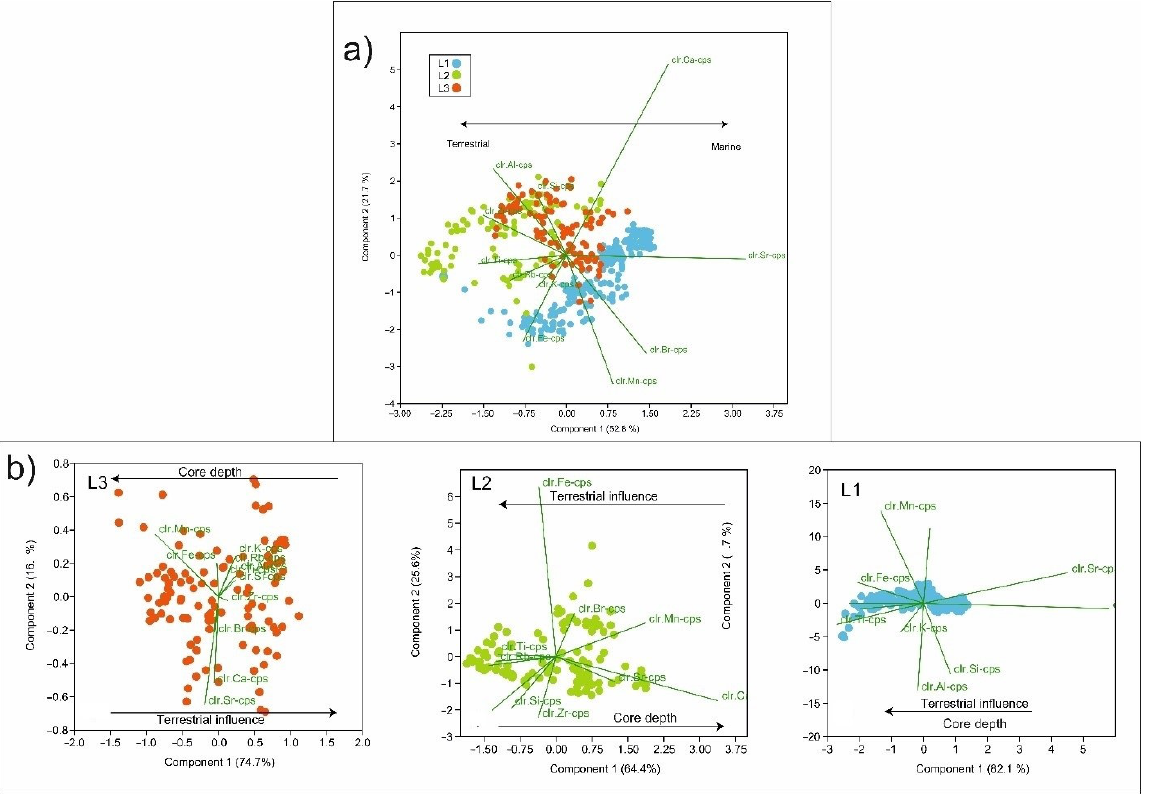
Figure 17. Compositional biplot: ( a ) all environments included; ( b ) discrimination between lithological unit L1 (marine environments), L2, and L3 (marine swamps with variable marine/terrestrial influence). Based on the geochemical data and the interpretation of the clr biplot (Figure 17), discrimination between lithological unit (L1, L2, L3) is clearly visible. Principal com- ponent PC1, which explains ~53% of the data variation, had positive loadings with the clr-transformed elements (Sr, Br) which were indicative for marine environments, while negative loadings were associated with terrestrial elements (Ti, Rb, Al, Zr, K). Based on these observations, lithological units were divided between marine environments (L1) and probable marine swamps (L2, L3) with variable marine/terrestrial